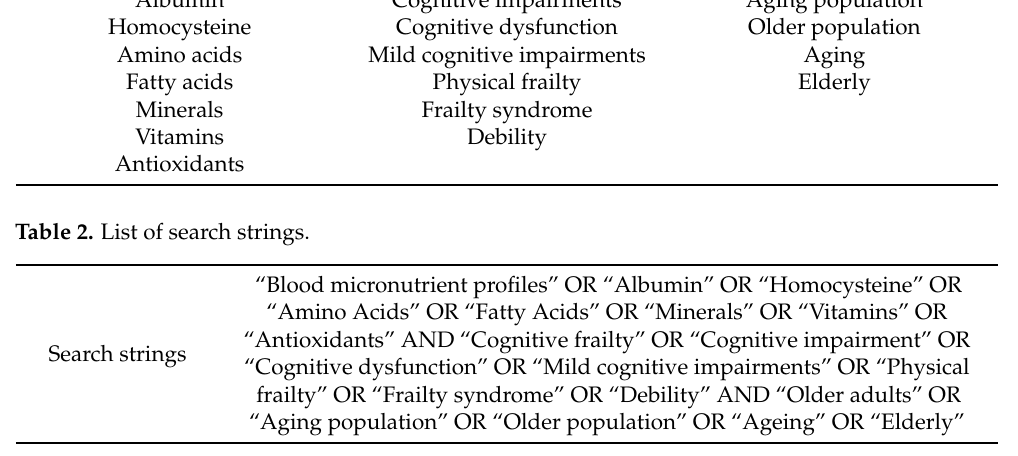
Table 1. Lists of keywords and synonyms generated as search terms. Blood Micronutrient Profiles